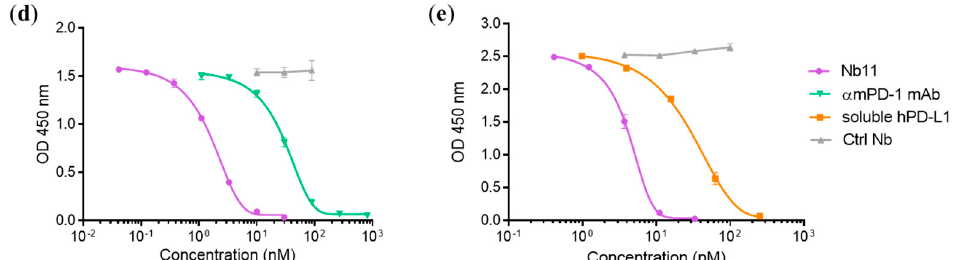
Figure 2. Identification of a PD-1 specific Nb able to inhibit PD-1 / PD-L1 interaction. Evaluation of Nb11 reactivity by flow-cytometry using HEK-293T cells transiently transfected with ( a ) mouse PD-1 (mPD-1), ( b ) human PD-1 (hPD-1) or ( c ) untransfected. Commercial monoclonal antibodies (mAbs) against mPD-1 and hPD-1 were included in this analysis, as well as their corresponding isotype controls and a control Nb (Ctrl Nb) with no relevant specificity. Inhibition curves of PD-1 / PD-L1 interaction using Nb11, for ( d ) mouse and ( e ) human molecules. In ( d ), ELISA plates were coated with mPD-L1-Fc and incubated with biotinylated mPD-1-Fc in the presence of di ff erent concentrations of Nb11, or of the indicated control molecules. In ( e ), ELISA plates were coated with hPD-1-Fc and incubated with Nb11 at di ff erent concentrations together with biotinylated hPD-L1-Fc. In this case, hPD-L1-Fc without biotin (soluble hPD-L1-Fc) was used as inhibition control. PD-1 / PD-L1 binding was detected with streptavidin-peroxidase. Data represent mean ± SD.